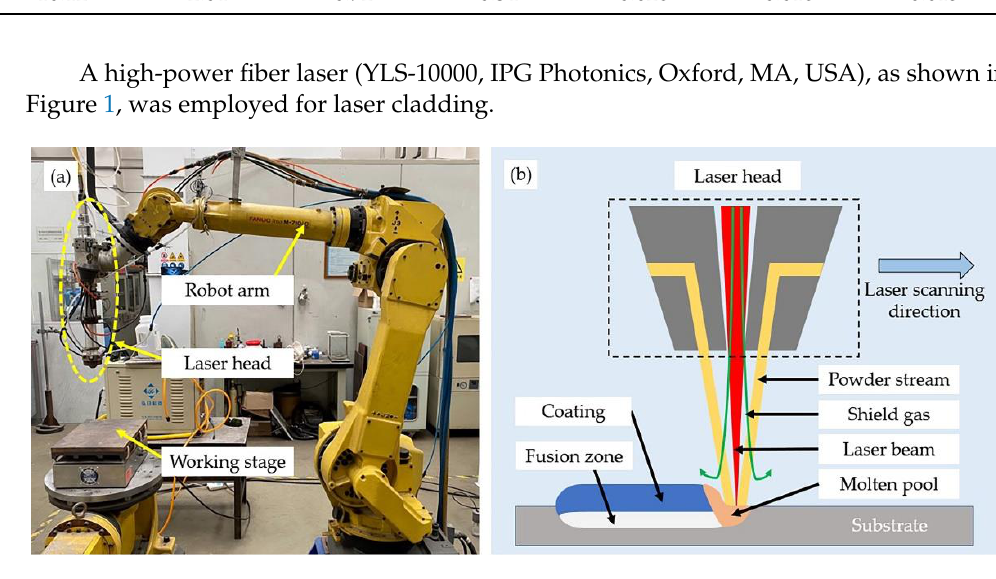
Figure 1. IPG YLS-10000 laser equipment: ( a ) overview of the equipment; ( b ) schematic diagram of the laser cladding process.